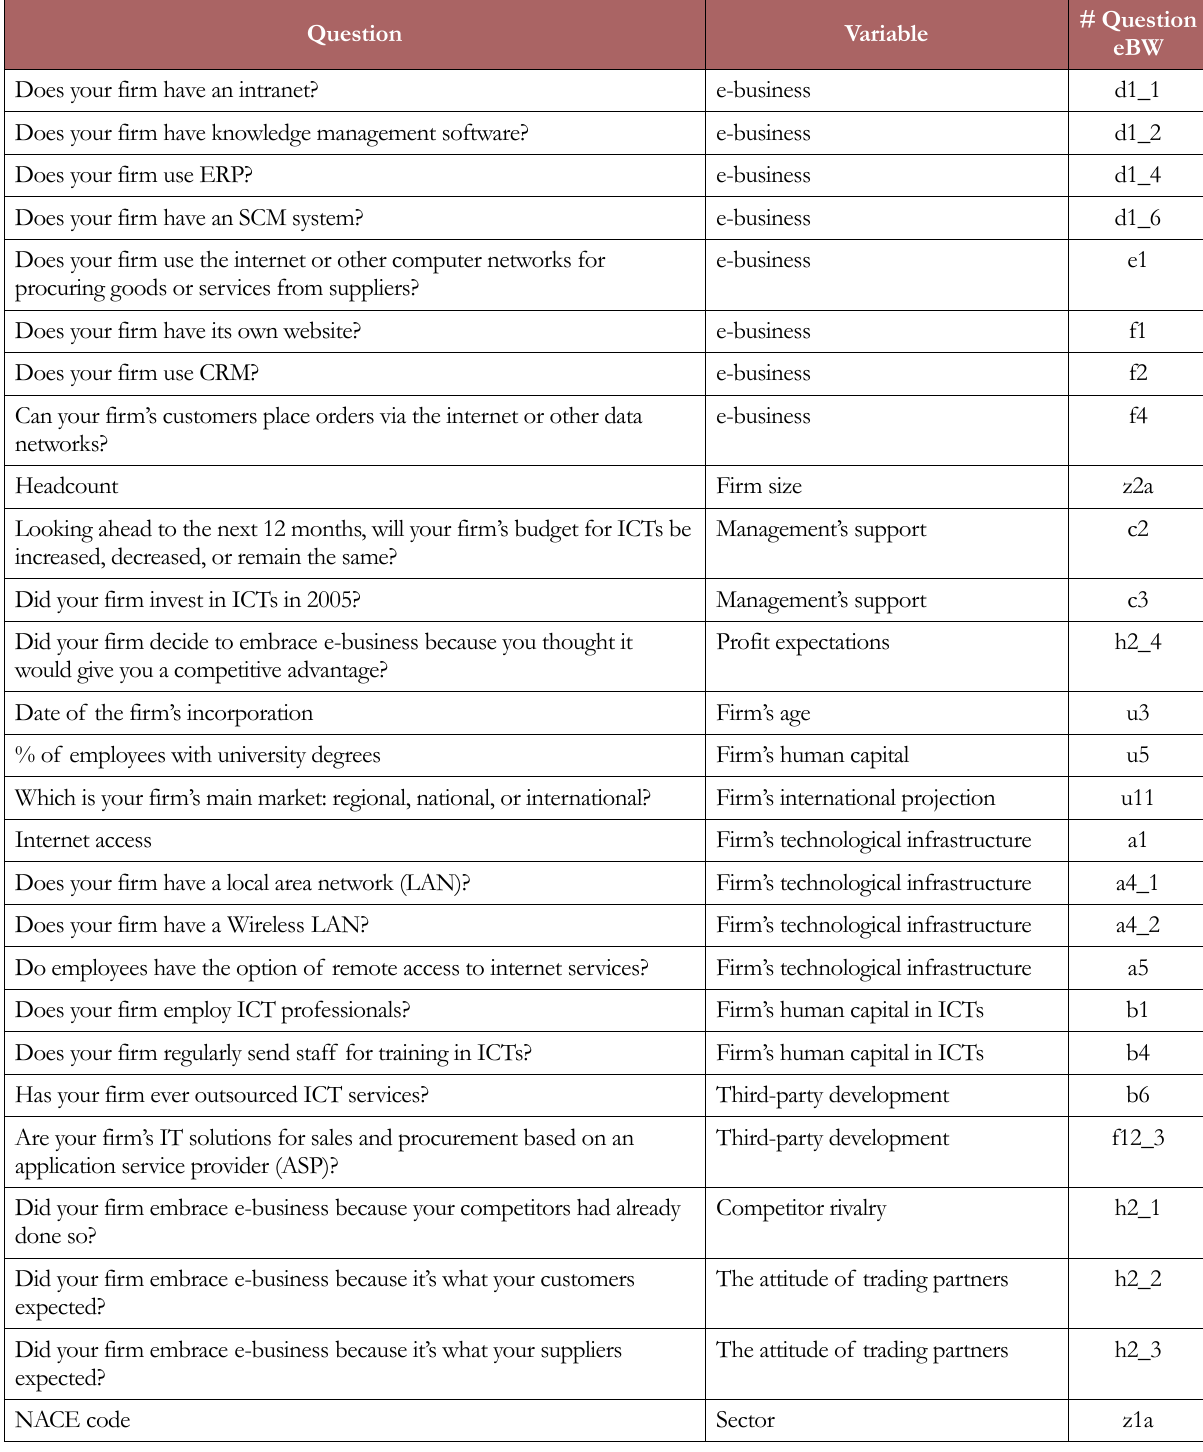
Table 1. Survey questions related to the model (based on the e-Business Watch questionnaire) These surveys were administered over the phone, using a standardised system supported by a digital questionnaire. Overall, between April and May 2006, interviews were held with 14,000 firms from 10 economic sectors in EU Member States, with most of the countries belonging to the European Economic Area (EEA), while others were